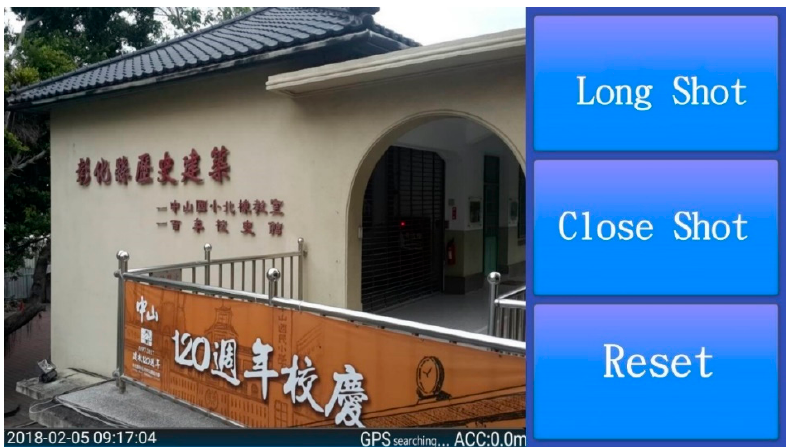
Figure 12. Page for taking snapshots of a building.